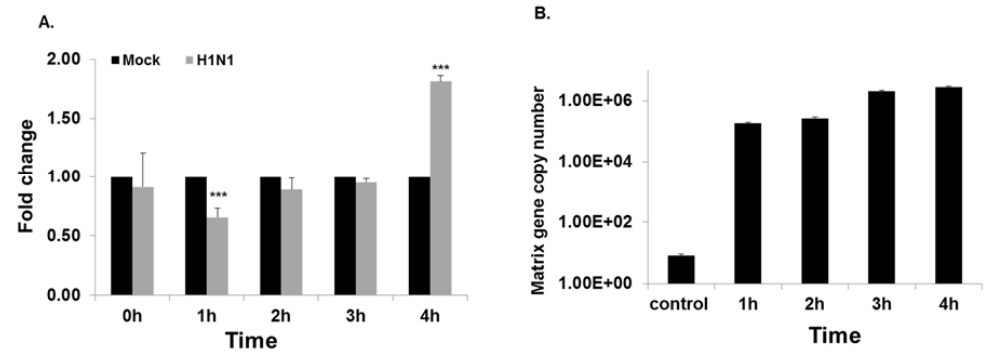
Figure 4 . Influenza infection modulates NFKBIB expression: ( A ) HBEpCs grown to 80% confluency were infected with IAV at an MOI of 1 or mock for 4 h and samples were taken every hour. RNA was extracted and complementary DNA (cDNA) was synthesized, and used for RT ‐ PCR analysis. NFKBIB expression was analyzed and normalized to glyceraldehyde phosphate dehydrogenase (GAPDH), and data are expressed as ± standard error of the mean (SEM), *** p < 0.001, n = 3 independent experiments; ( B ) influenza virus matrix gene copy number was analyzed from the RNA extracted from HBEpCs infected with IAV for 4 h; n = 3 independent experiments analyzed in duplicates. Control is the mock infected.